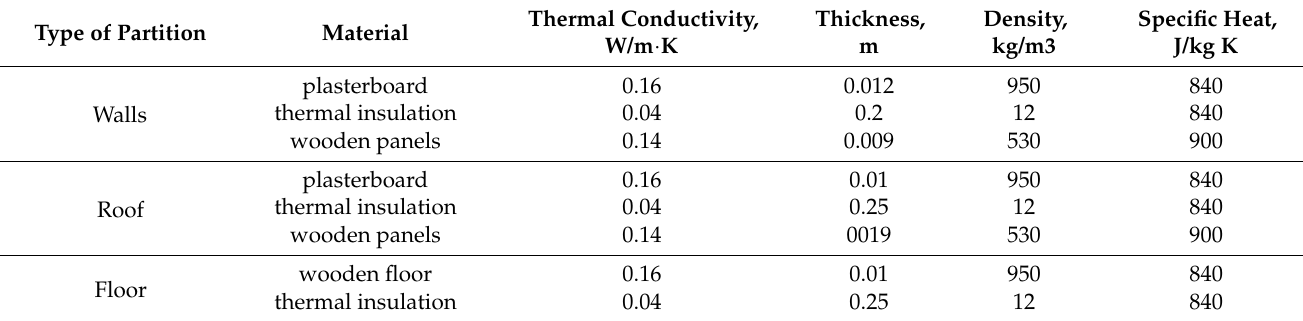
Table 1. Material data of the basic variant of the